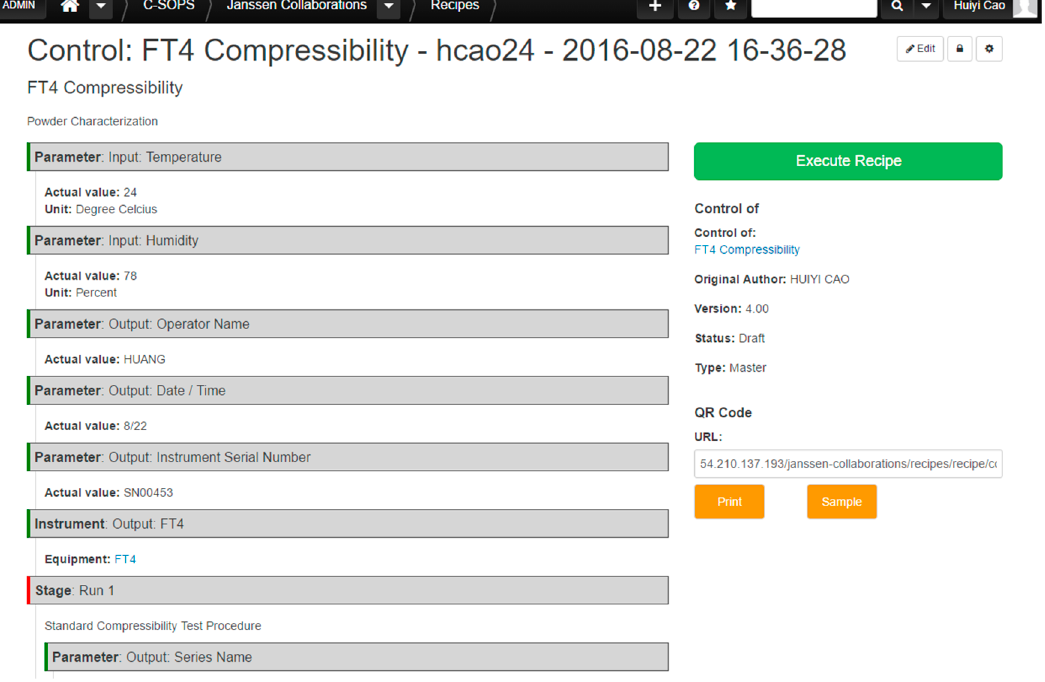
Figure 14. Example of control recipe.